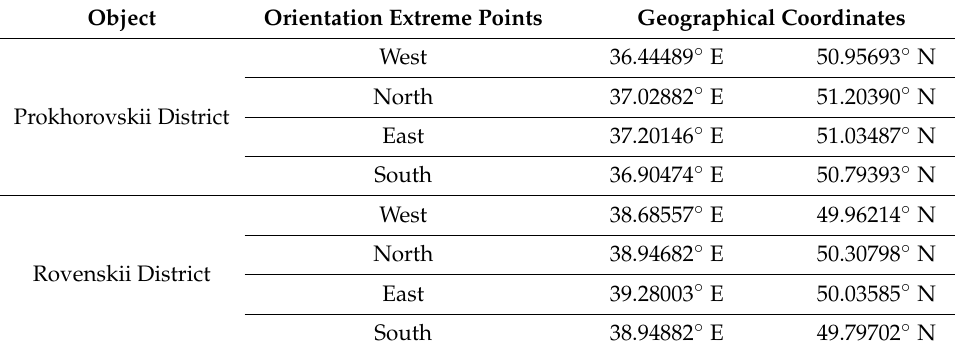
Table 1. Geographic coordinates of soil sampling areas.